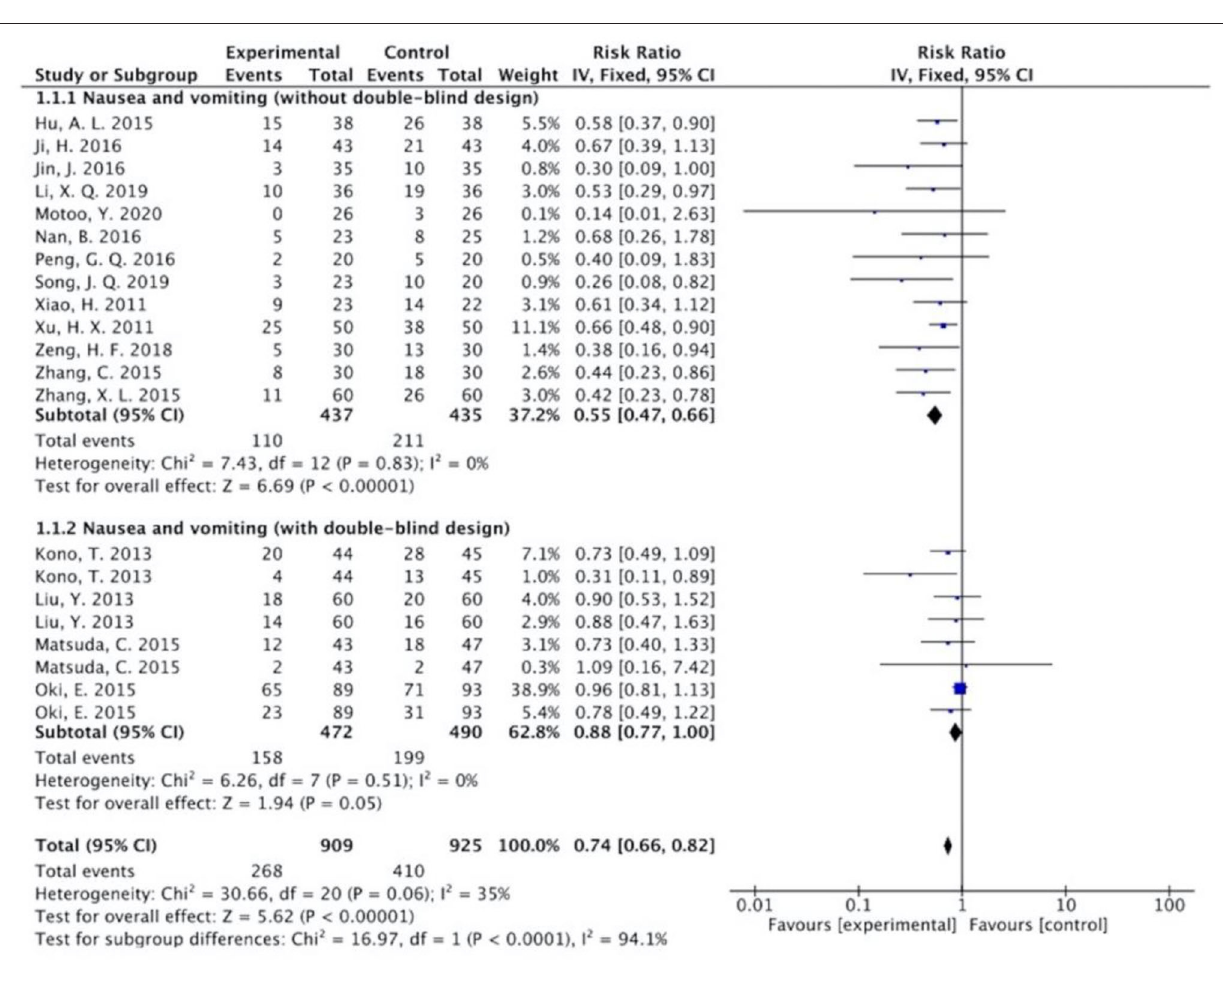
A. sinensis + G. uralensis + A. macrocephala , G. uralensis + A. macrocephala + P. ternata , and G. uralensis + A. macrocephala + A. membranaceus ; three combinations of four plants: G. uralensis + C. reticulata + P. radix + C. pilosula , A. sinensis + G. uralensis + A. macrocephala + C. reticulata , and